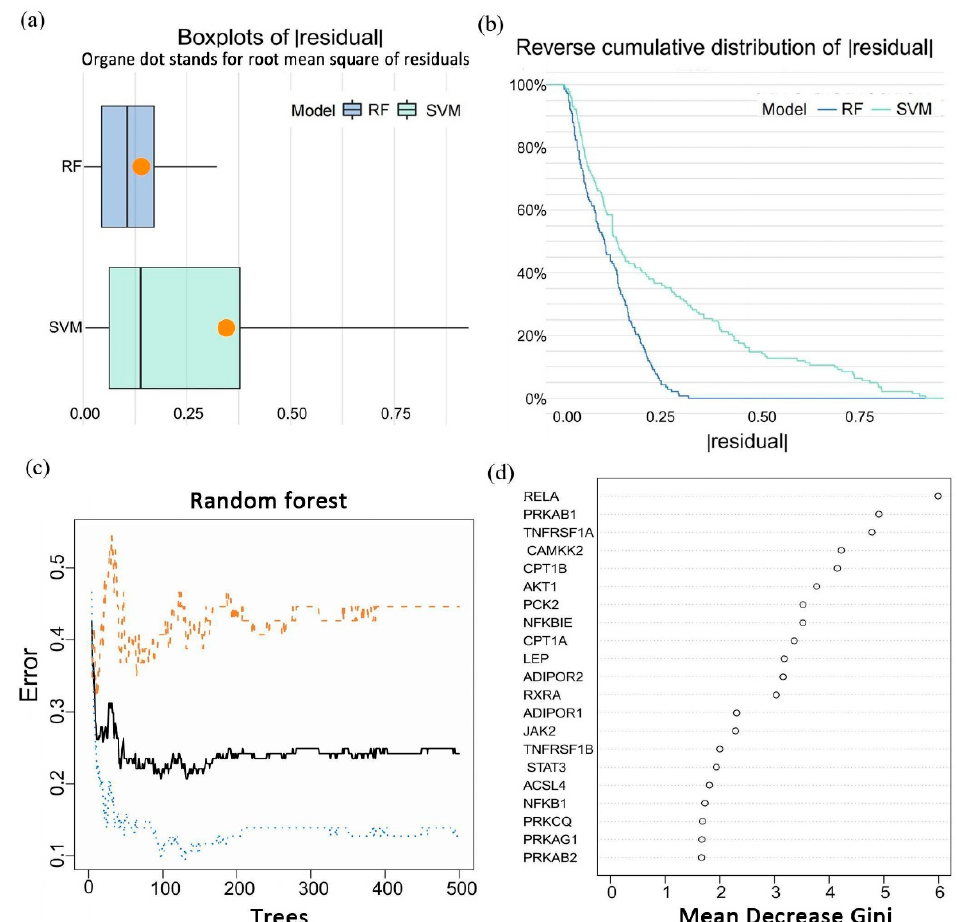
Figure 3. Identification of a five-gene signature in epilepsy. ( a,b ) Residual comparison between RF and SVM models shows that RF has a smaller residual. ( a ) The comparison of residuals between RF and SVM models shows smaller residuals in the RF model. RF, random forest; SVM, support vector machine. ( b ) The comparison of residuals between RF and SVM models shows smaller residuals in the RF model. RF, random forest; SVM, support vector machine. ( c ) The error rate varies with the number of classification trees in the random forest model. Setting trees with the appropriate number will reduce the error rate of the RF model. The blue line represents the error rate in the healthy controls, the yellow line for epilepsy samples, and the black line for all samples. ( d ) The importance scores of 21 candidate genes are sorted based on the Gini index. The lower the Gini index, the more accurate the classification results. The top 5 genes were chosen for subsequent analysis.